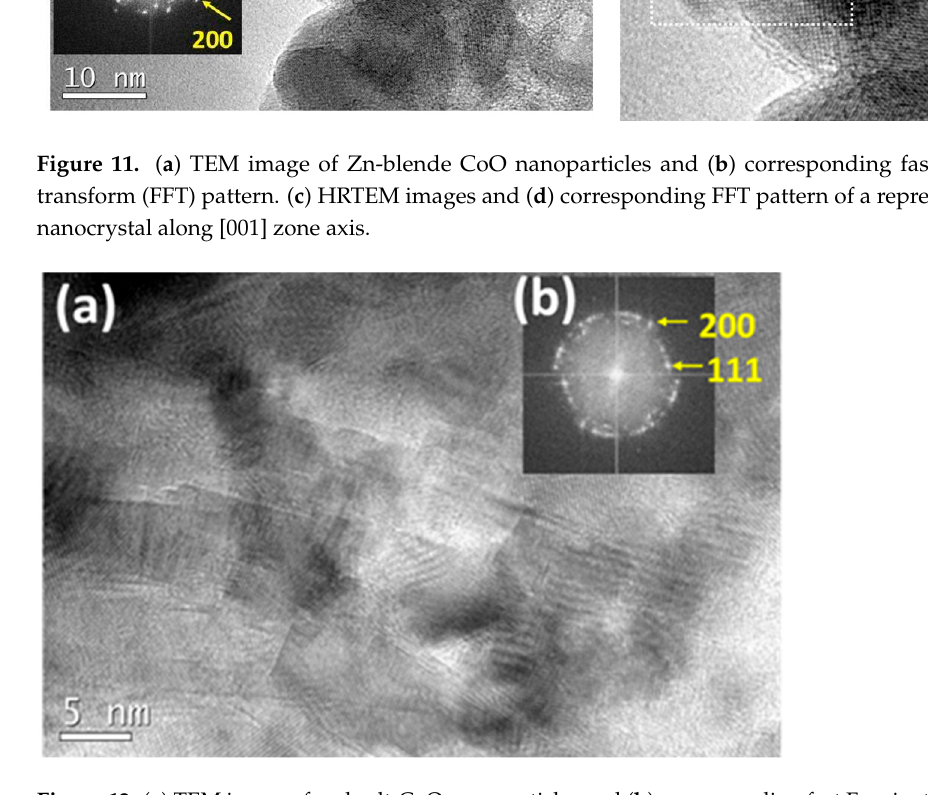
Figure 11. ( a ) TEM image of Zn-blende CoO nanoparticles and ( b ) corresponding fast Fourier transform (FFT) pattern. ( c ) HRTEM images and ( d ) corresponding FFT pattern of a representative nanocrystal along [001] zone axis.